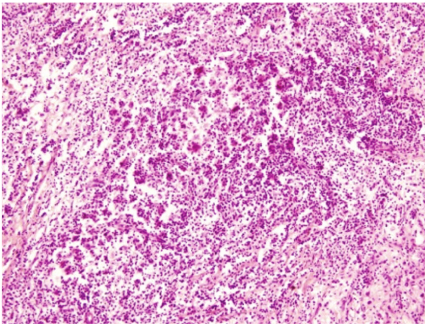
Figure 2: Photomicrograph showing inflammatory nature of the lesion (H&E, ×